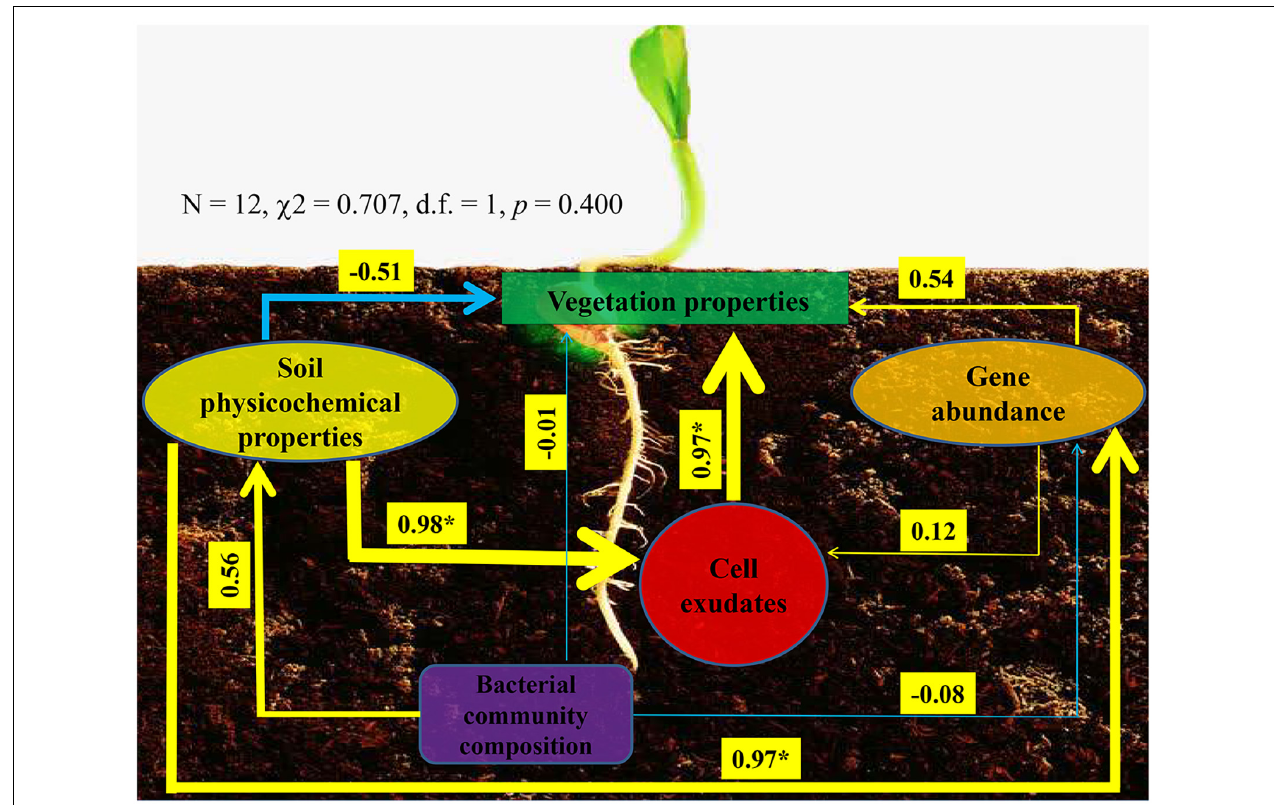
FIGURE 6 | Structural equation model showing the hypothesized causal relationships among vegetation properties, soil physicochemical properties, phosphorus-cycling-related gene abundance, cell exudates (include enzyme and indole acetic acid), and bacterial community composition. The width of the arrows presents the strength of the standardized path coefficient. The blue lines indicate negative path coefficients, and yellow lines reflect positive path coefficients. Values above the lines indicate path coefficients between two parameters. Asterisks denote significance ( p <